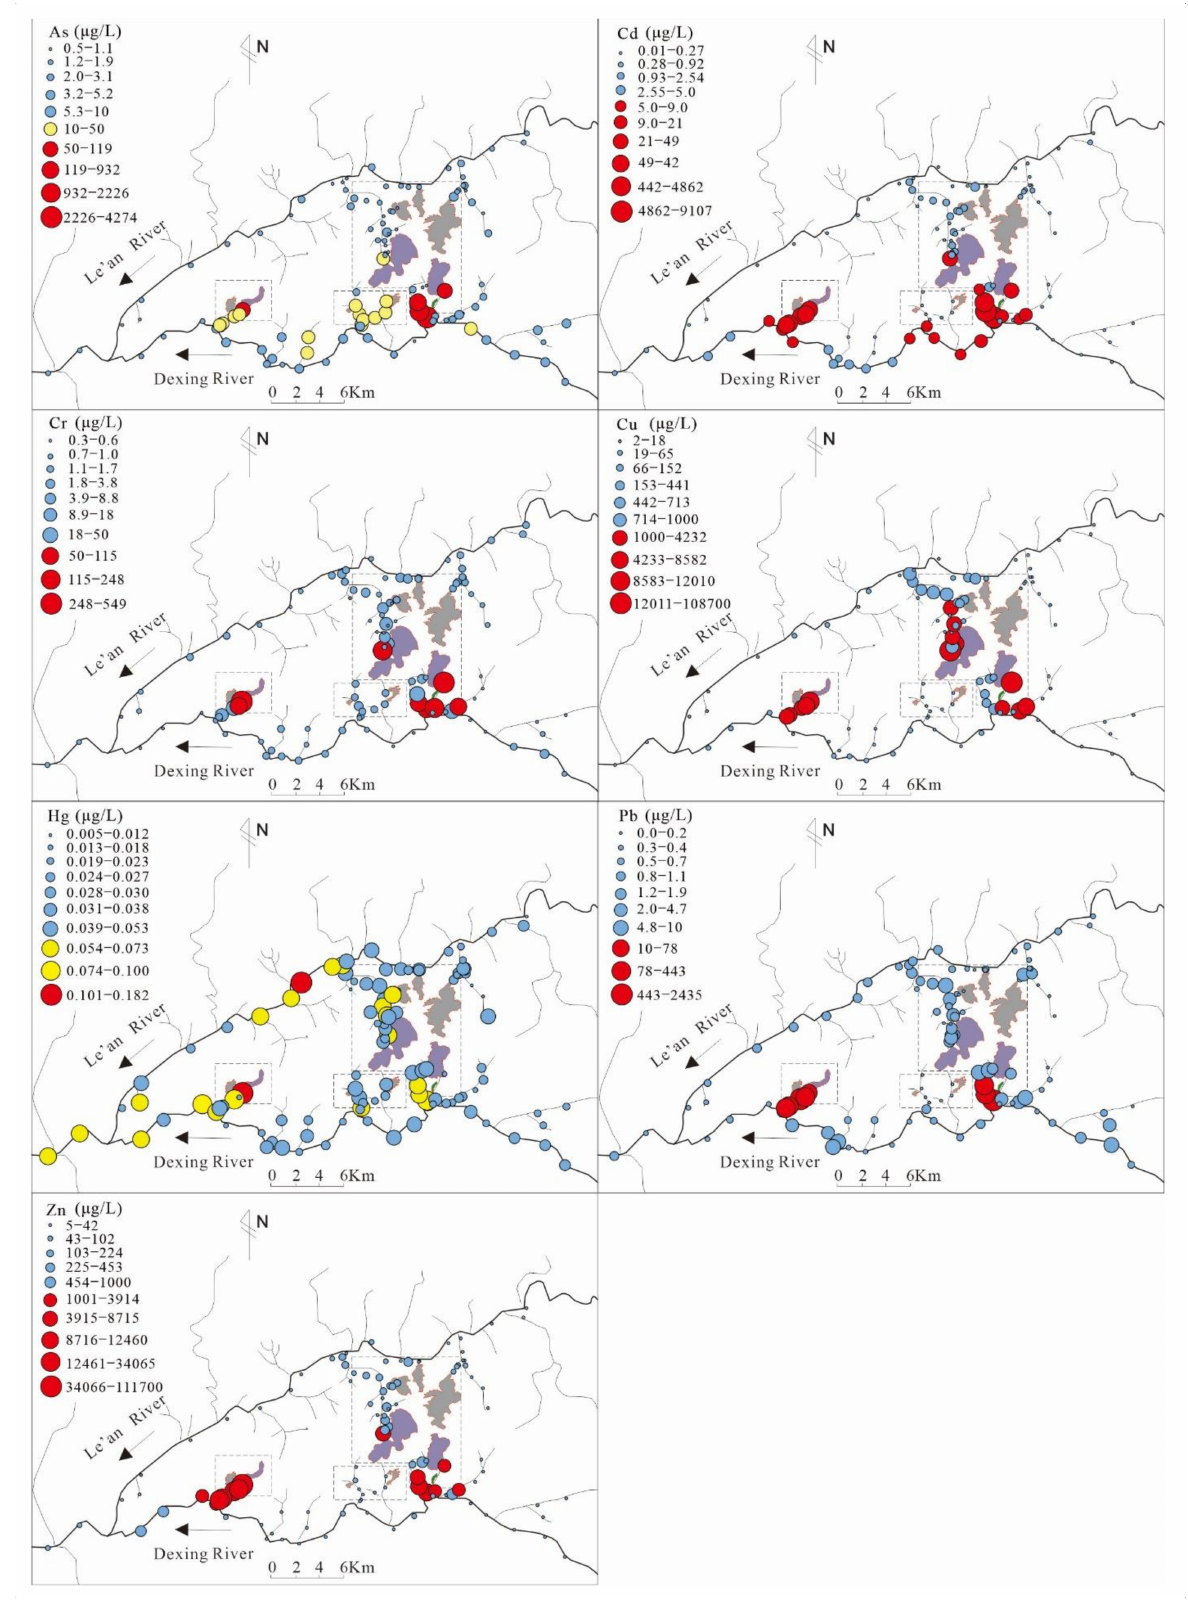
Figure 4. HMs distribution in surface water